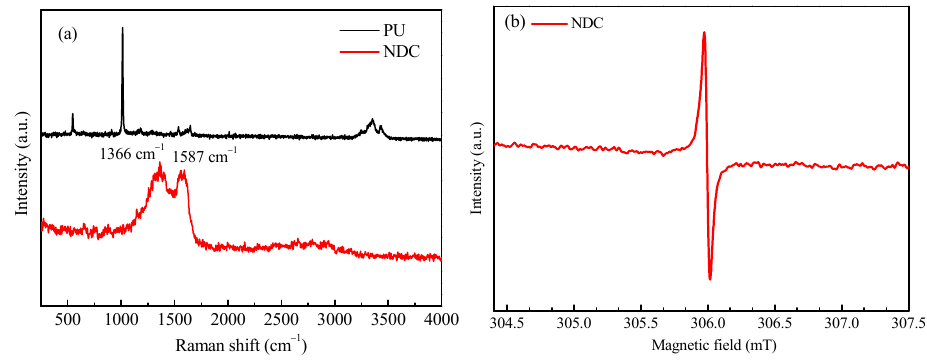
Figure 5. ( a ) Raman spectra of PU and NDC, ( b ) Low temperature EPR spectra of NDC.